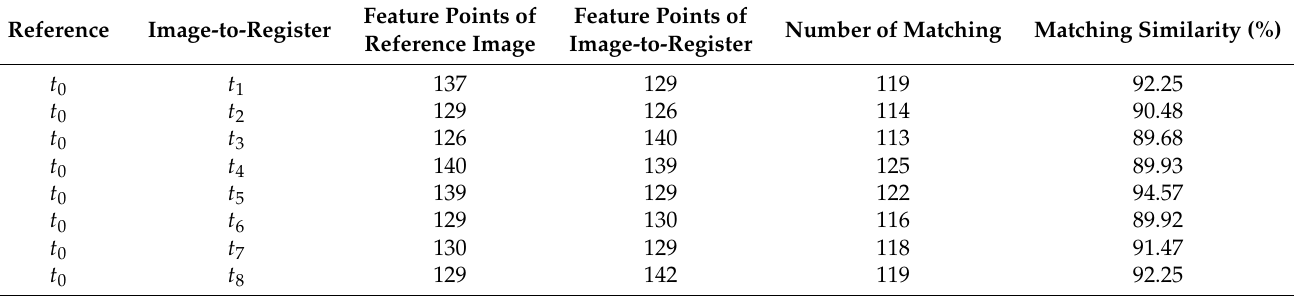
Table 3. Similarity of feature point matching between adjacent frame